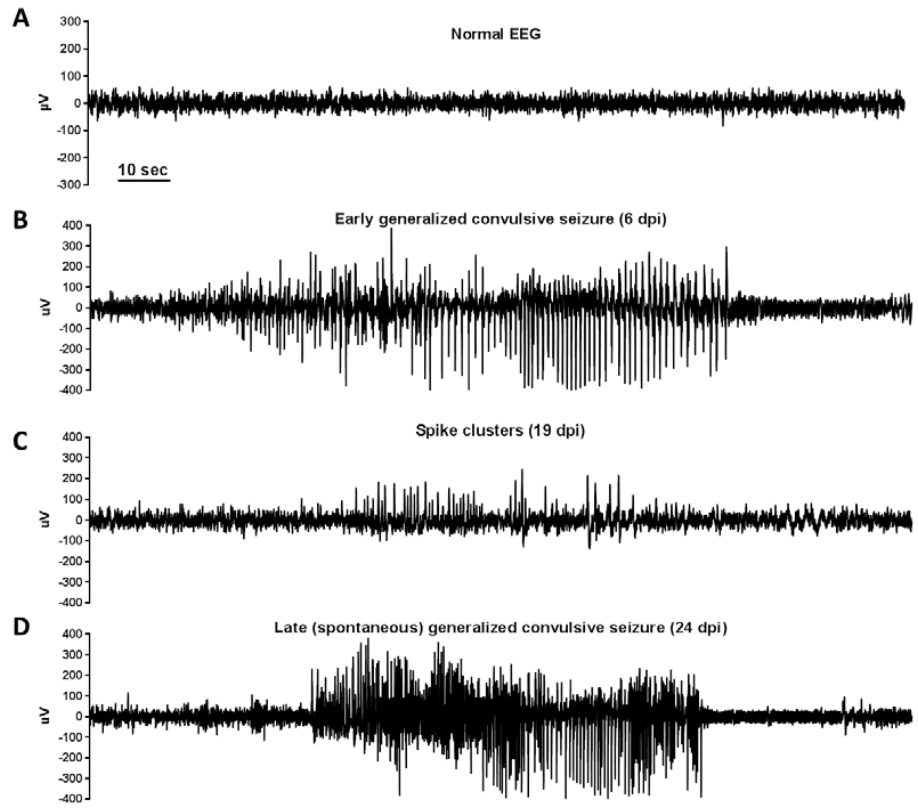
Figure 5. EEG recordings in TMEV-DA-infected C57BL/6 mice: TMEV-DA-infected C57BL/6